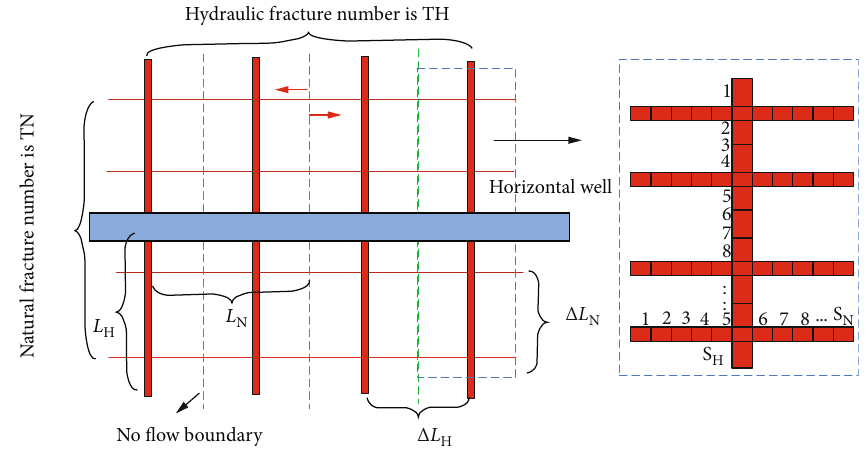
Figure 1: Physical model and discretized fracture segments of a complex fracture